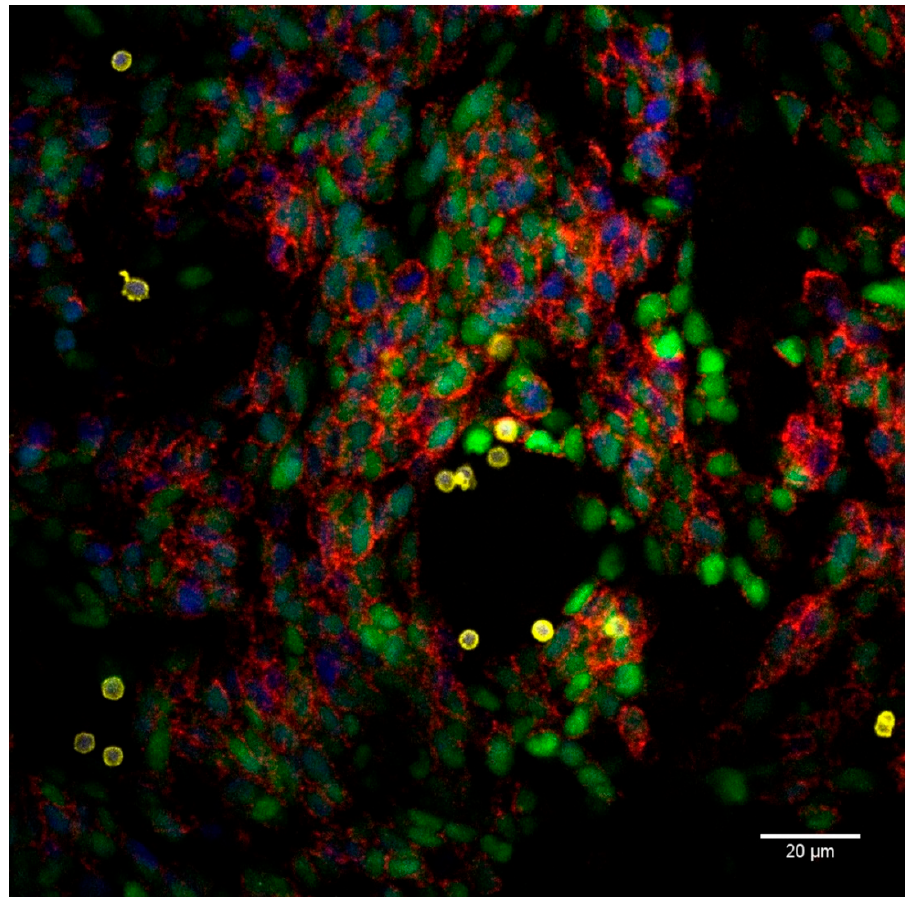
Figure 4. Image of a Duolink® in situ proximity ligation assay (PLA) showing Cluster of differentiation (CD)56 homodimer formation among tumor cells. Representative example of a SH-SY5Y-eGFP (green) culture (with natural killer cells (CD45; yellow)), mounted with 4 ′ ,6-diamidino-2-phenylindole (DAPI) (blue), whereby the CD56–CD56 interaction is visualized as red dots ( n = 9). Scale bar: 20 µm.